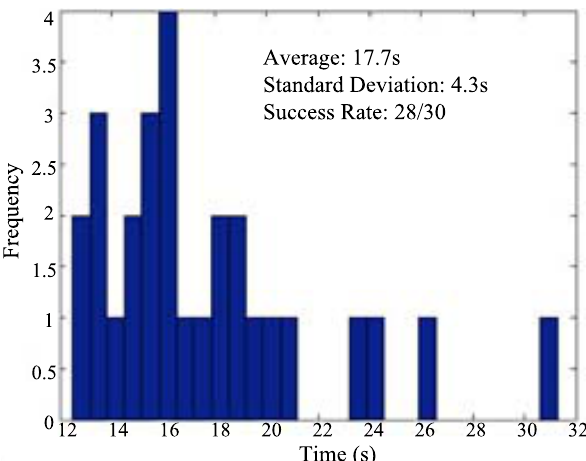
Figure 7. Histogram showing the time distribution of the 30 sheath- ing trials that were used to approximate the